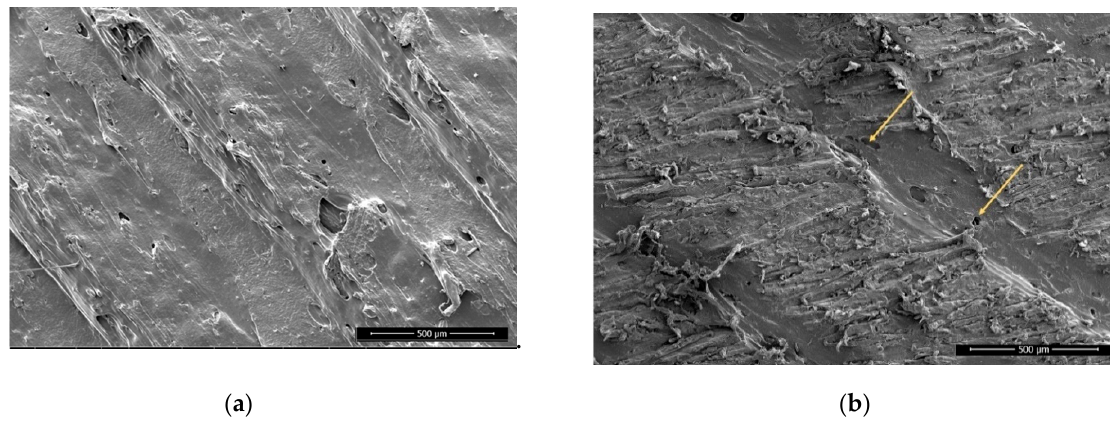
Figure 6. Wood-PLA, non-sanded, non-treated ( a ) and sanded ( b ) 100× magnification. Arrows showing high porosity and open voids in surface.